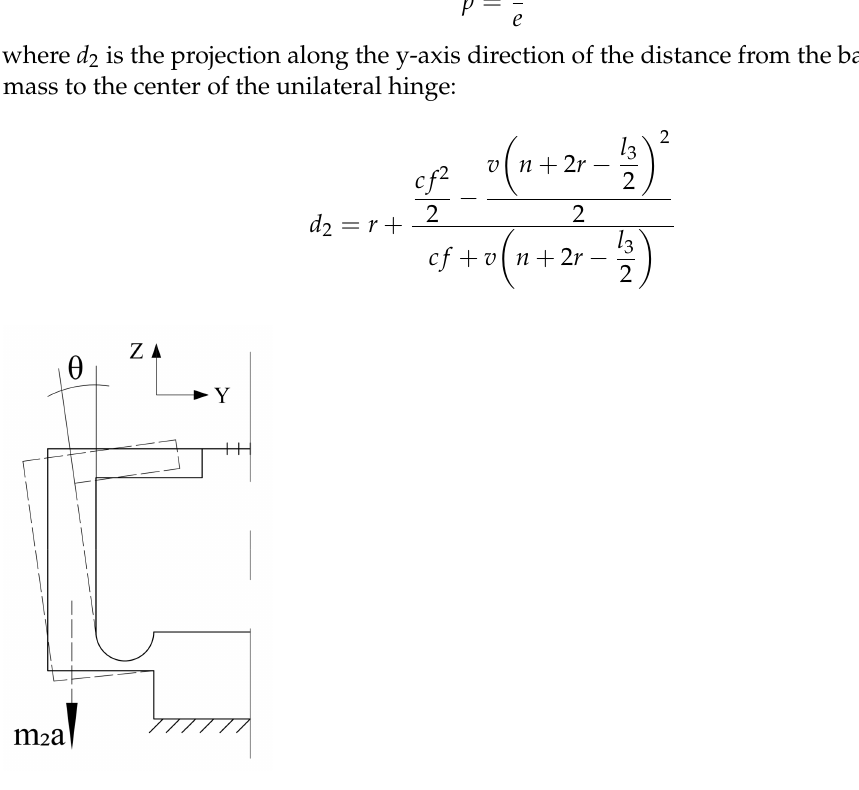
Figure 5. Force analysis diagram of z-direction